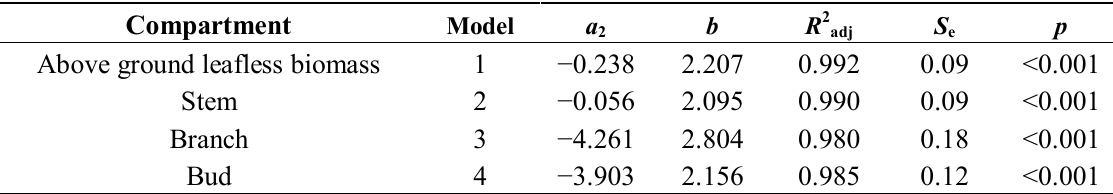
Table 3. Estimated allometric parameters (applicable for Equation 3) and statistical output data for total above ground leafless biomass and individual tree compartments against dbh (df = 1,28).